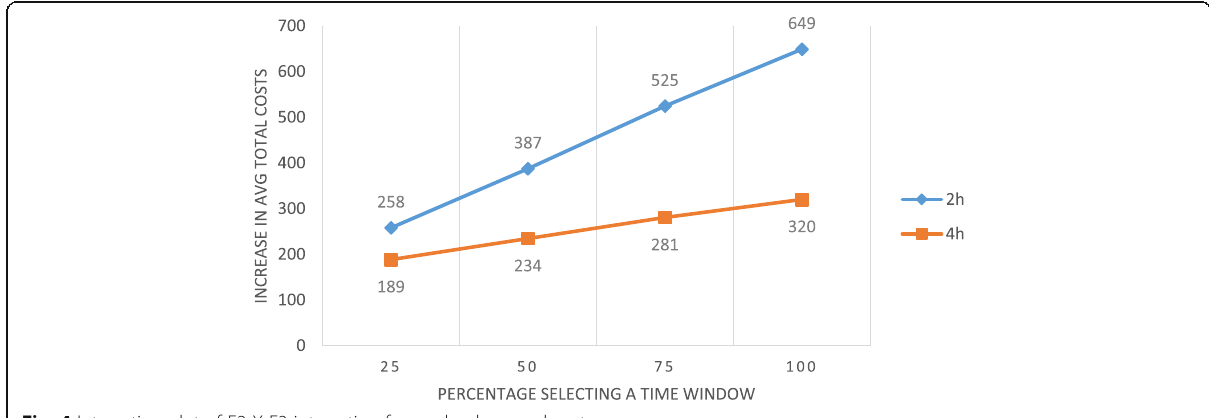
Fig. 4 Interaction plot of F2 X F3 interaction for randomly spread customers